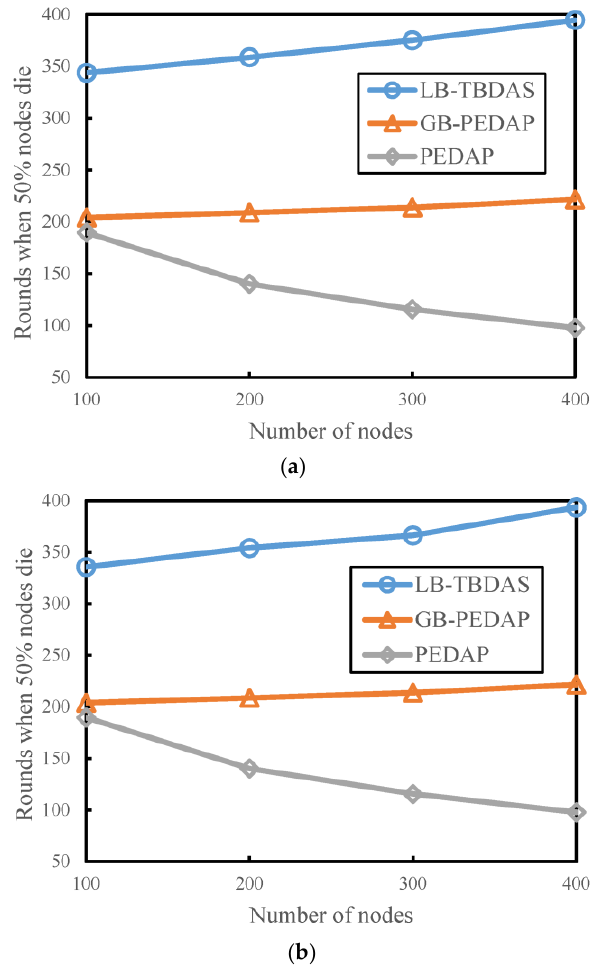
Figure 6. Number of rounds when 50% of nodes die versus number of nodes: ( a ) Cm = 4; ( b ) Cm = 7.